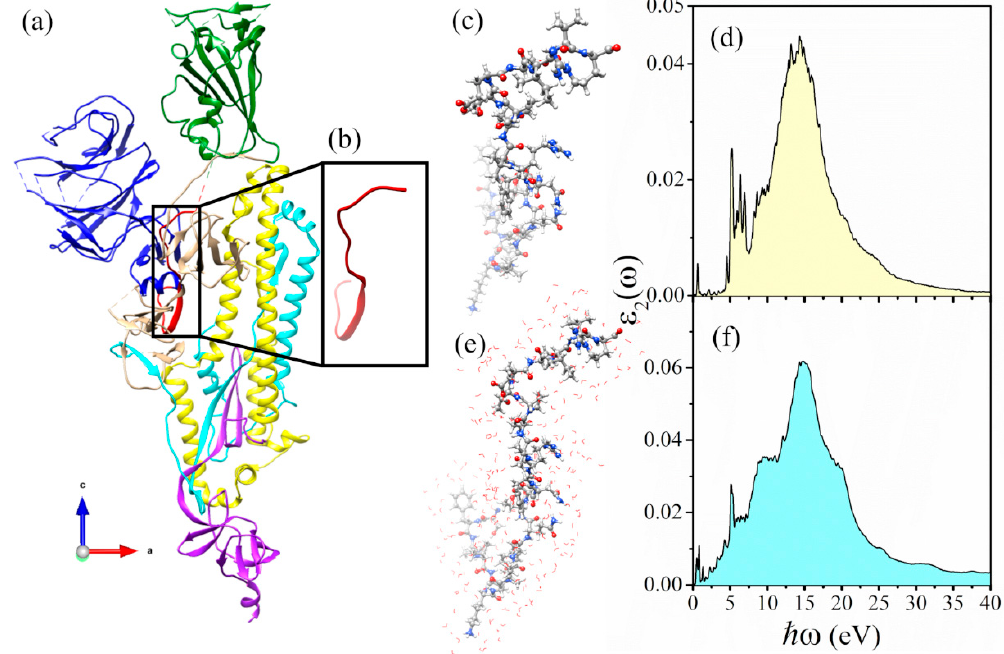
Figure 5. ( a ) Chain A of spike protein (6VSB); ( b ) ribbon for SD1; ( c ) ball and stick model of SD1; ( d ) ε 2 ( ω ) for dry SD1 model; ( e ) ball and stick model and ( f ) ε 2 ( ω ) of SD1 with 300 H 2 O molecules.